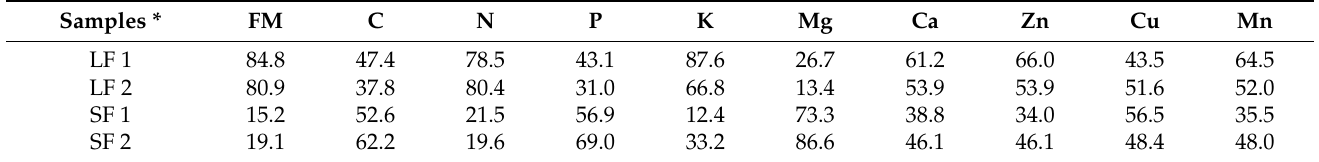
Table 4. Distribution (%) of FM and nutrients in SF and LF after mechanical separation of